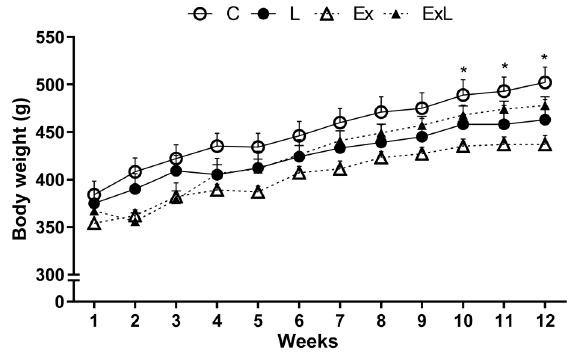
Figure 1. Evolution of body weight during 12 weeks of experiment. Data are reported as mean ± SEM. C: Control (n=12); L: